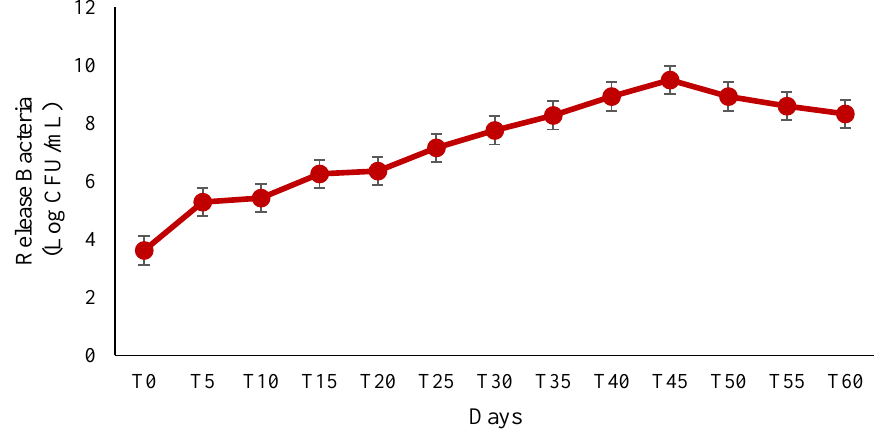
Figure 7. SEM of microcapsules with B. velezensis . Adapted from [64].